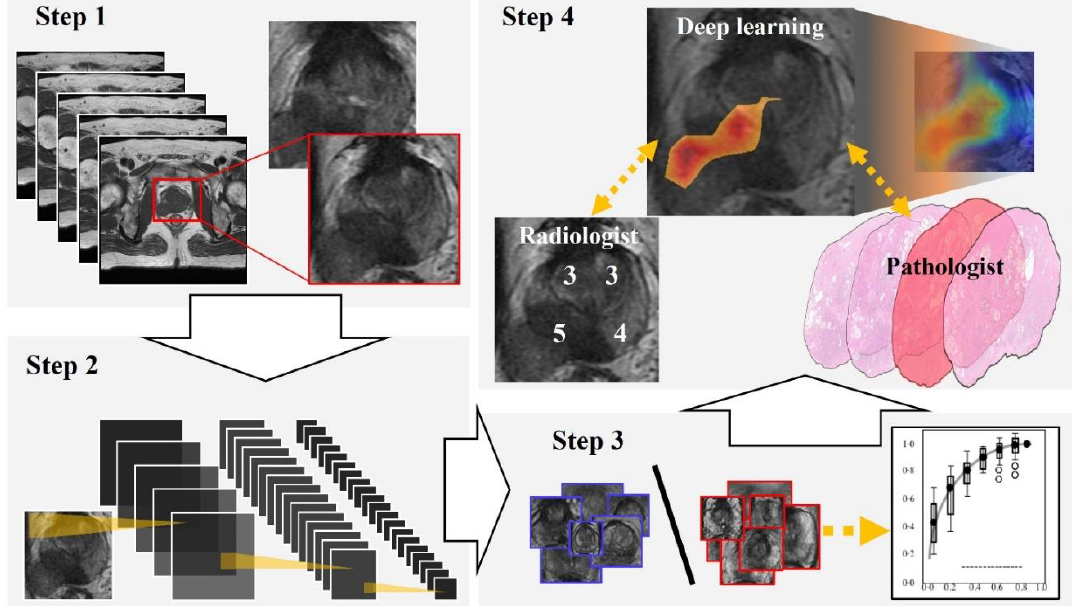
Figure 1. Flowchart of our study. Step 1: We extracted a rectangular region of the prostate from within the magnetic resonance (MR) images and adjusted the image size to 256 × 256 pixels. Step 2: For